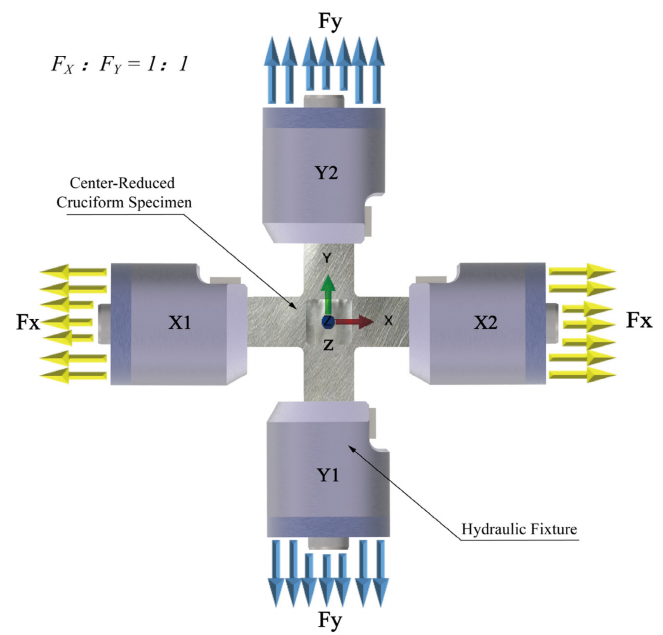
Figure 2. Schematic diagram of the equal biaxial tensile